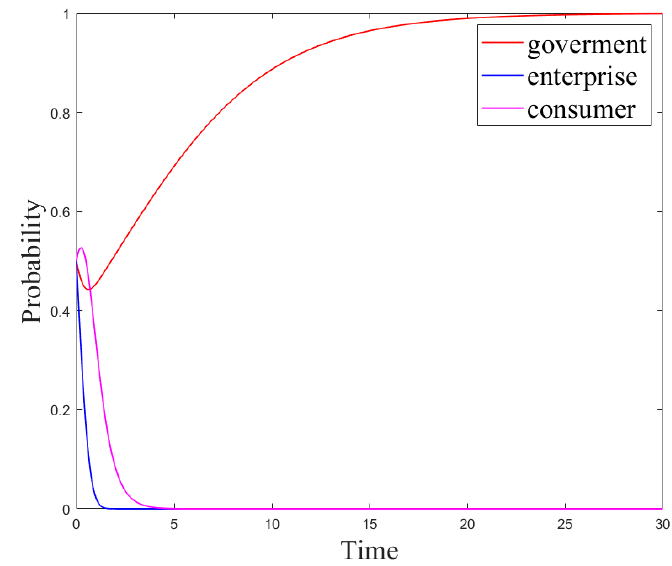
Figure 6. Evolution results under Scenario 2.